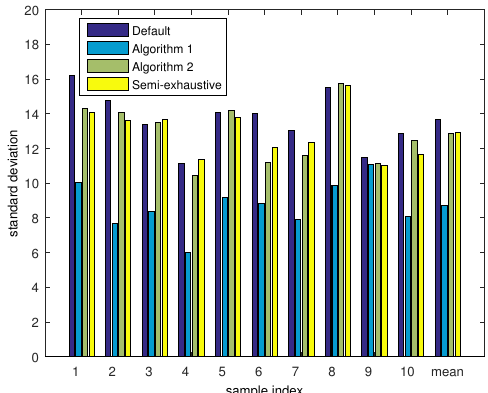
Figure 10. Standard deviations of MS